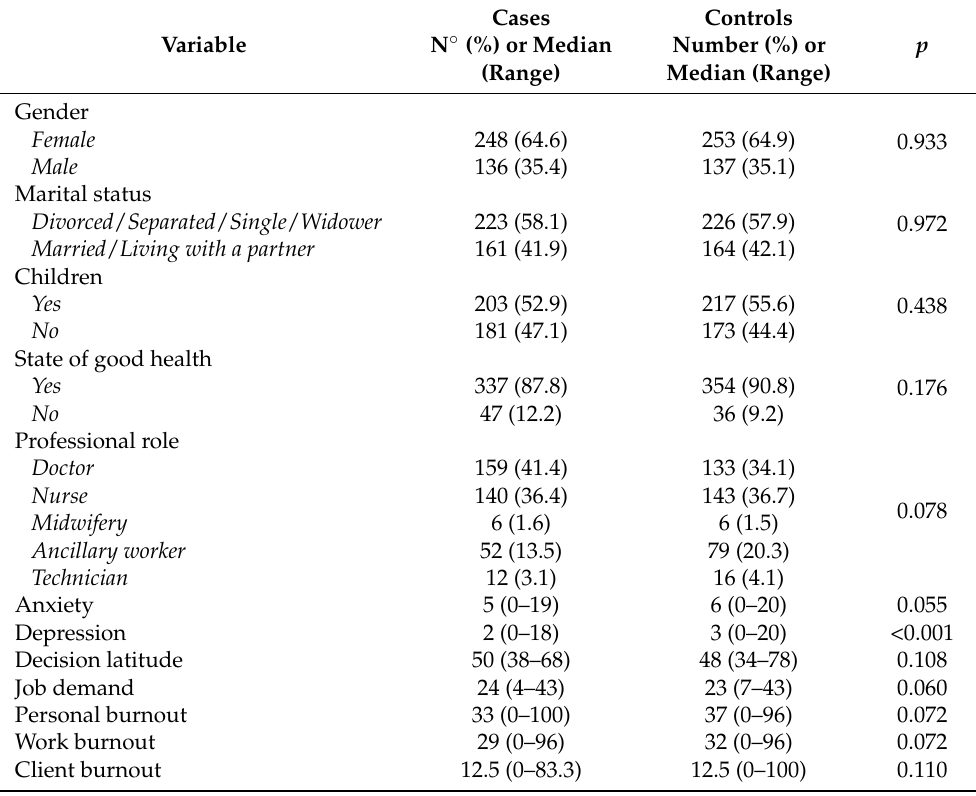
Table 2. Univariate